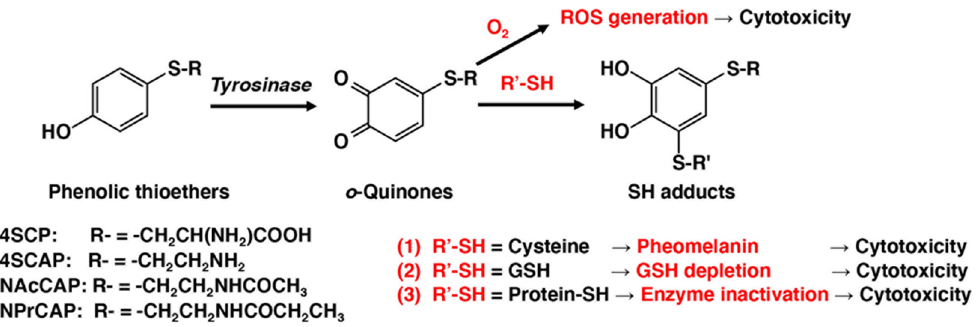
Figure 2. Mechanisms of cytotoxicity of o -quinones produced by tyrosinase-catalyzed oxidation of phenolic thioethers.